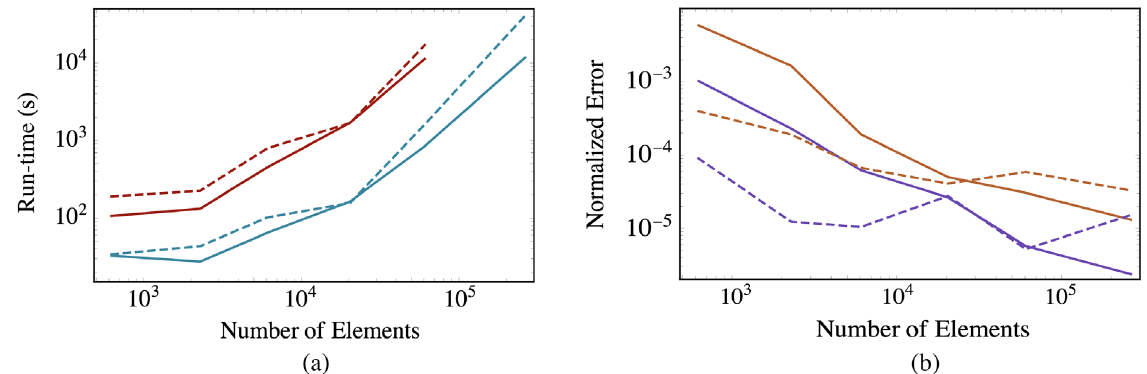
FIG. 7. The left plot shows the computation time for PISCS in serial (red lines) and parallel (blue lines) operation, and the right plot relates the normalized error in the electric potentials (purple lines) and fields (orange lines) as a function of the number of boundary elements for the electric dipole. The solid and dashed lines correspond to the results when Dirichlet and Neumann boundary conditions, respectively, are